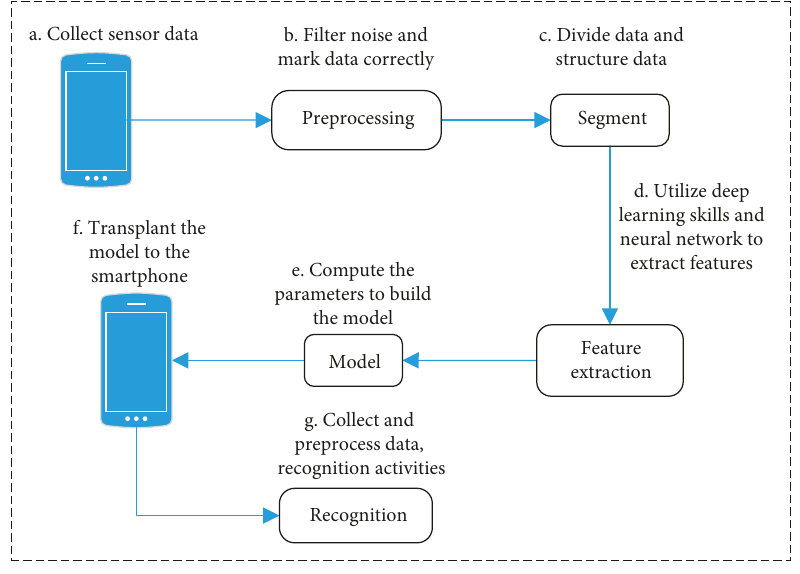
Figure 1: Flowchart of transportation recognition. Table 1: Types of transport states.